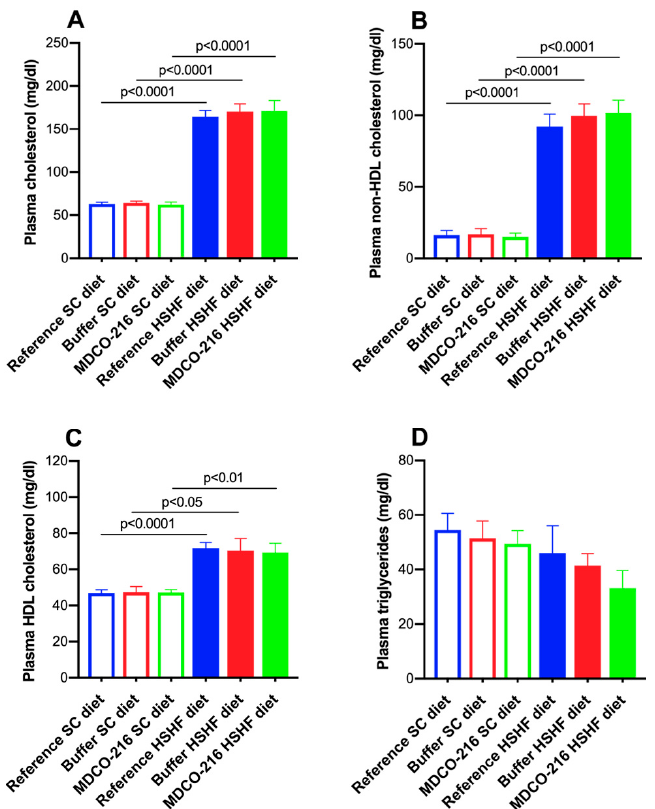
Figure 3. Total cholesterol ( A ), non-HDL cholesterol ( B ), and HDL cholesterol plasma levels ( C ) and plasma triglyceride levels ( D ) in female C57BL/6N mice at the time of sacrifice. All data represent means ± SEM ( n = 8).